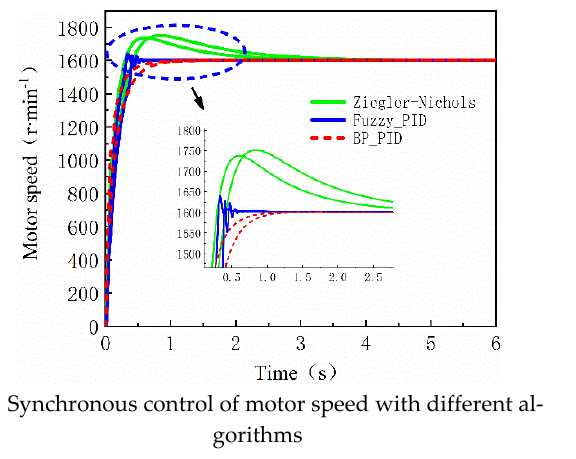
Figure 20. Synchronous control of motor speed.